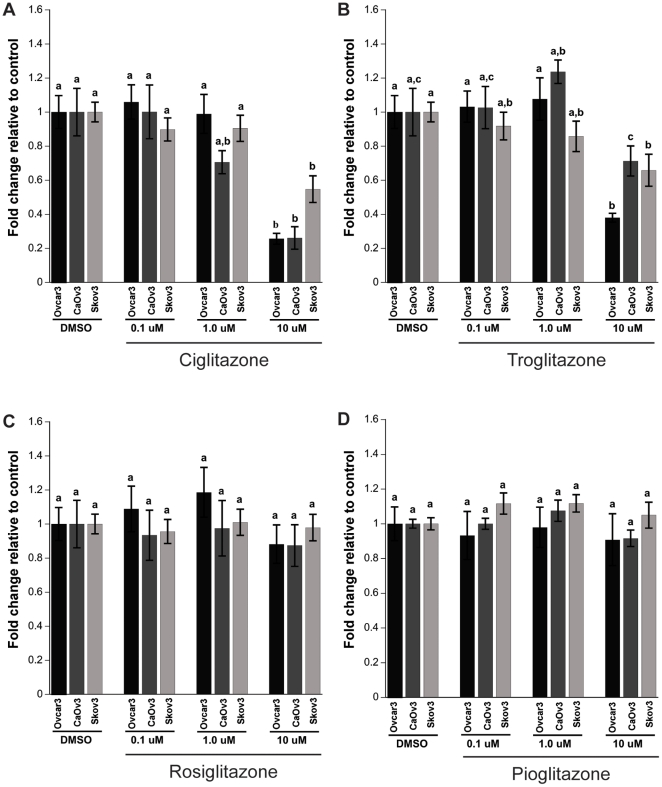
Effect of TZD treatment on Ovcar3, CaOv3 and Skov3 cell proliferation.Ovarian cancer cells were serum starved for 24 hours and treated for an additional 24 hours with vehicle control (DMSO) or 0.1, 1.0 or 10 µM of CGZ (A), TGZ (B), Rosi (C), or Pio (D). Cell proliferation was assessed with the MTS assay. Results are the means ± SEM for at least 3 measurements from three individual experiments. Statistical analysis was performed within each cell line. Bars that do not share a letter designation are significantly different within a treatment group (p<0.05). Black bars: Ovcar3, Grey: CaOv3, Light grey: Skov3.